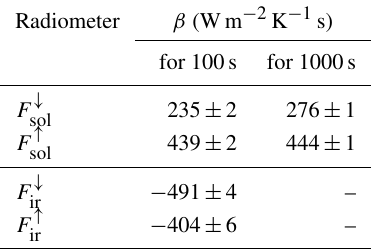
Table 1. Coefficients for dynamic thermal offset correction β of the individual radiometers of BACARDI and their uncertainty esti- mates. To detrend the data, two high-pass filters (100 and 1000s) are applied for the